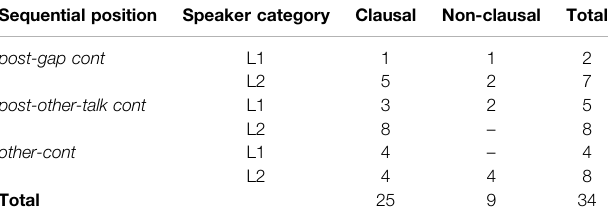
TABLE 1 | Distribution of “ and then ” -prefaced turn continuations in the collection. Sequential position Speaker